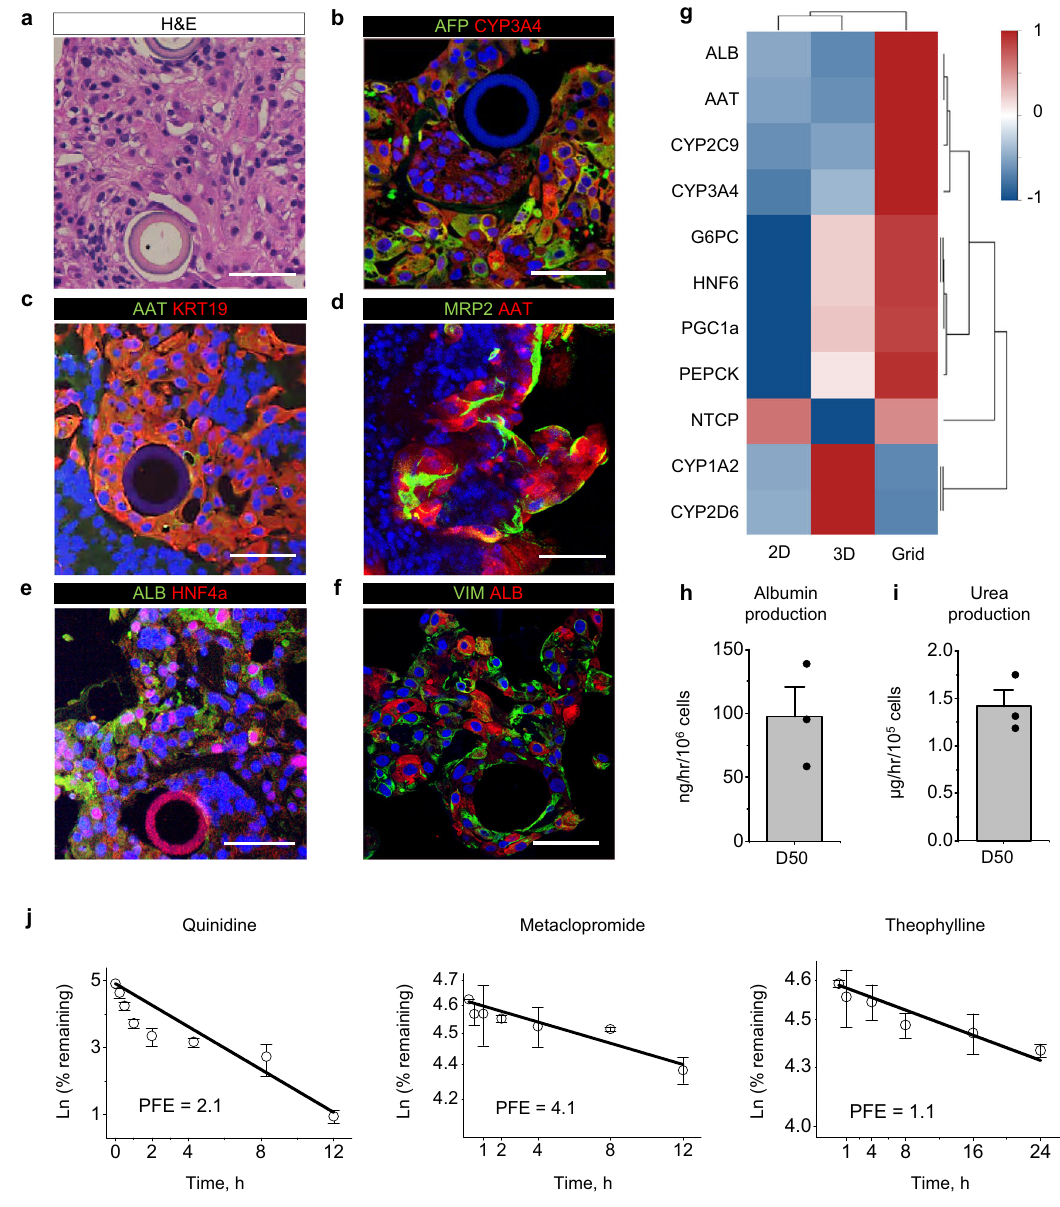
Fig.6|Functionalimprovementinperfusedliverconstructs.a Hematoxylinand eosin of a transverse section of liver tissue construct with hepaptocyte-like mor- phology and no visible indication of apoptosis. b Immuno fl uorescence images showing presence of Alpha Fetoprotein (AFP) and hepatic P450 cytochrome CYP3A4, c Alpha-1 antitrypsin (AAT) and Cytokeratin 19 (KRT19). d Multiple drug resistance-associated protein (MRP2) and α 1-antitrypsin (AAT), e Basic hepatic markersalbumin(ALB)andhepaticnuclearfactor(HNF4 α )expression( f )Vimentin (VIM)andalbumin(ALB).Scalebar70 µ m.Representativeimageson( a )through( f ) wereacquiredinthreeindependentexperiments;allexperimentsproducedsimilar results. g Heatmap representation of fold change gene expression levels normal- ized to control 2D cell culture and compared to standard hepatic organoids and